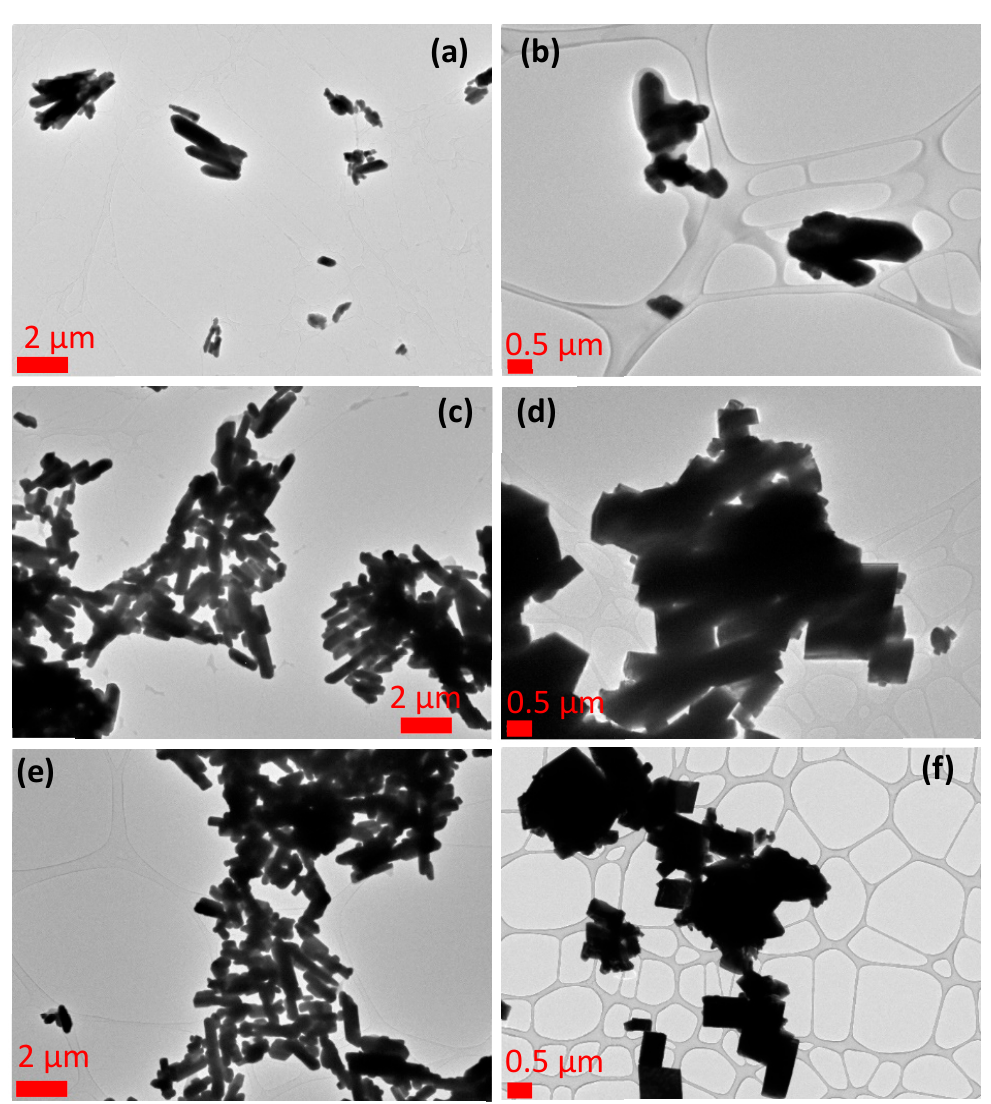
Figure 4. TEM Images before ( a , c , e ) and after ( b , d , f ) BaSO 4 precipitation; ( a ) and ( b ) PCL/Ba (50/50), ( c ) and ( d ) PCL/Ba (10/90), and ( e ) and ( f ) PCL/Ba (2.5/97.5).